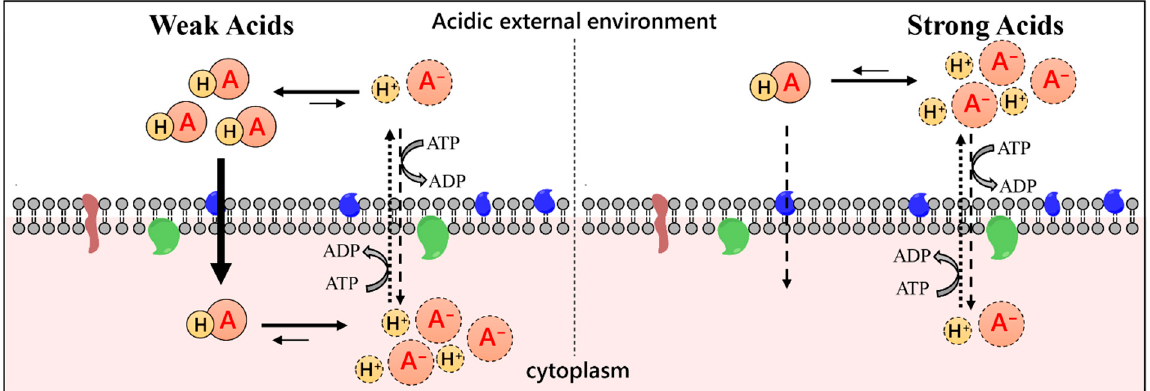
Figure 3. Possible mechanisms of bacterial acidification by weak (organic) and strong (inorganic) acids. Weak acids can easily diffuse into bacteria cytoplasm where they are dissociated and acidify the internal medium. In contrast, strong acids are usually dissociated and will not reach the bacterial cytoplasm as easily as weak acids. A − –anion, H + –proton, HA–acid.